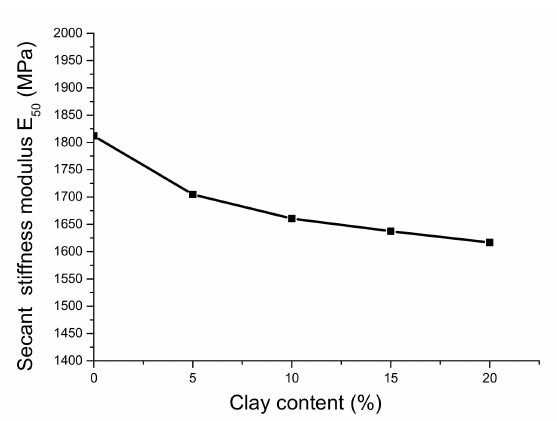
Figure 5. Secant sti ff ness modulus E 50 of sediments by clay content (%).